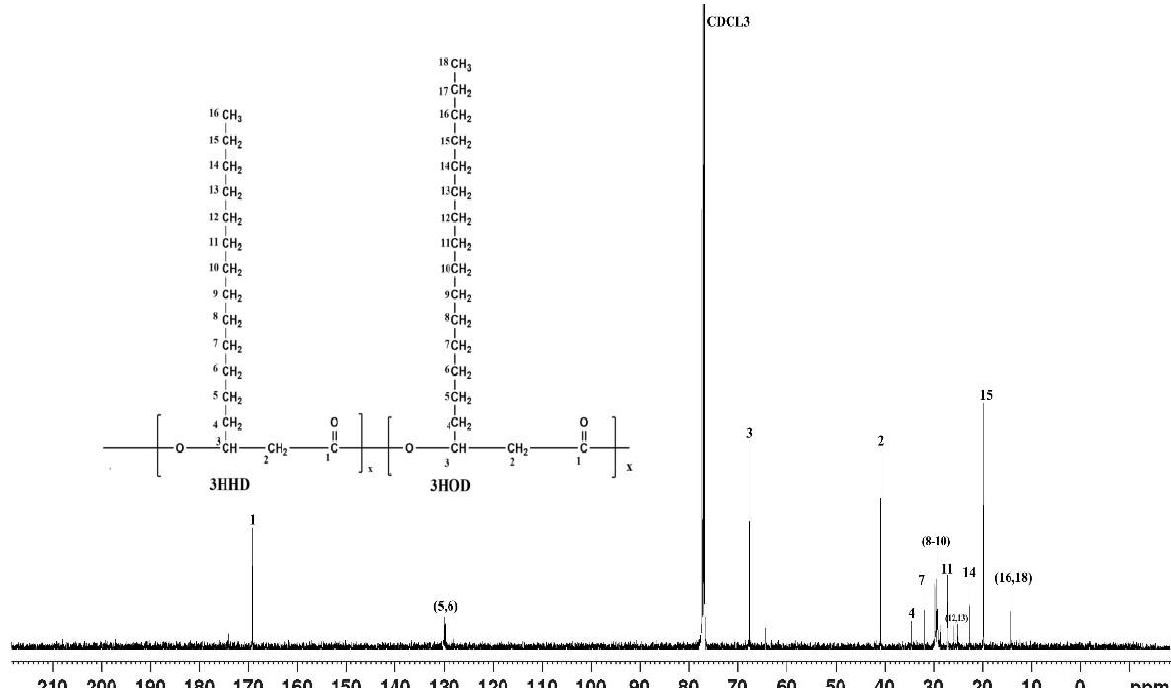
Figure 3. The 13 C NMR spectrum of the PHA produced by Acinetobacter sp. strain AAAID-1.5 in a biosynthesis medium containing used transformer oil as a carbon source.